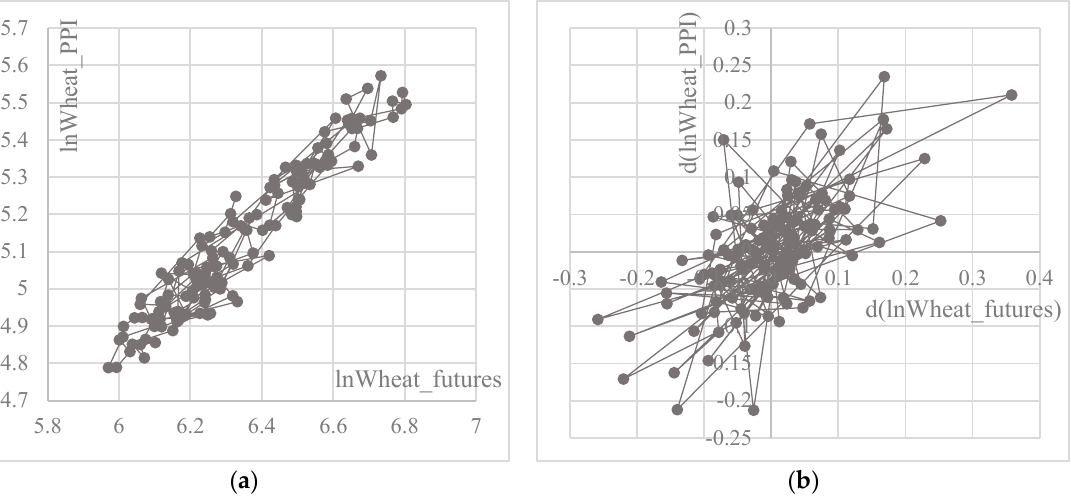
Figure 2. Correlation of the price and increments of futures and cash prices of wheat in the USA. ( a ) correlation between ln(values); ( b ) correlation between increments of log values.